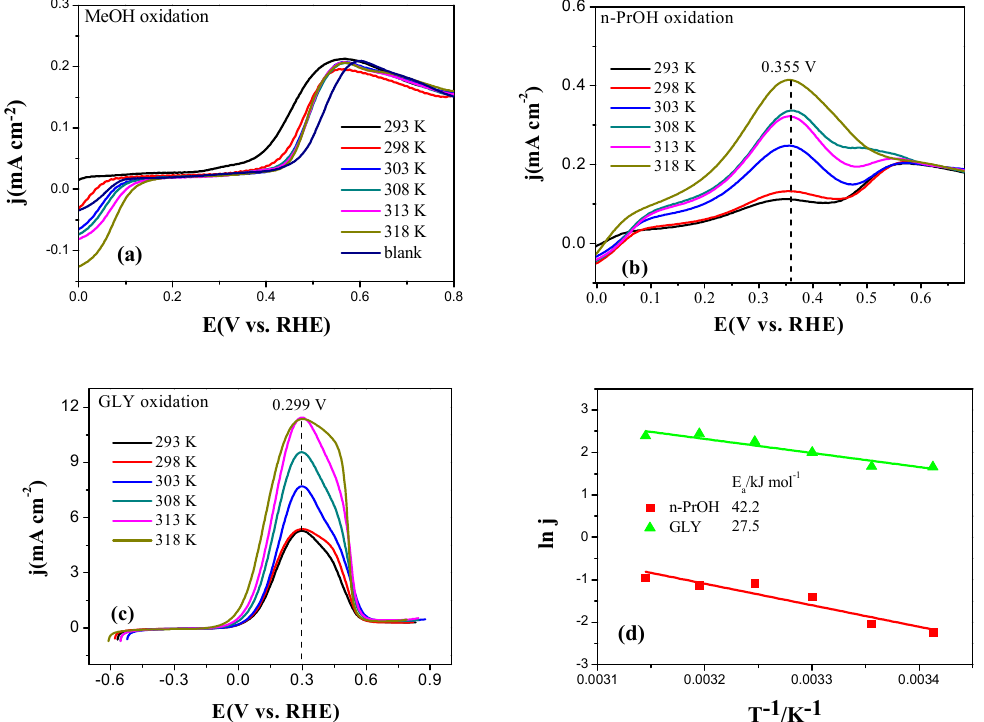
Figure 12. ( a – c ) Linear scan curves (LSVs) of Au electrode in 0.1 M KOH + 0.025 M alcohol; ( d ) Arrhenius plot of alcohol eletro-oxidation on Au at peak potentials.